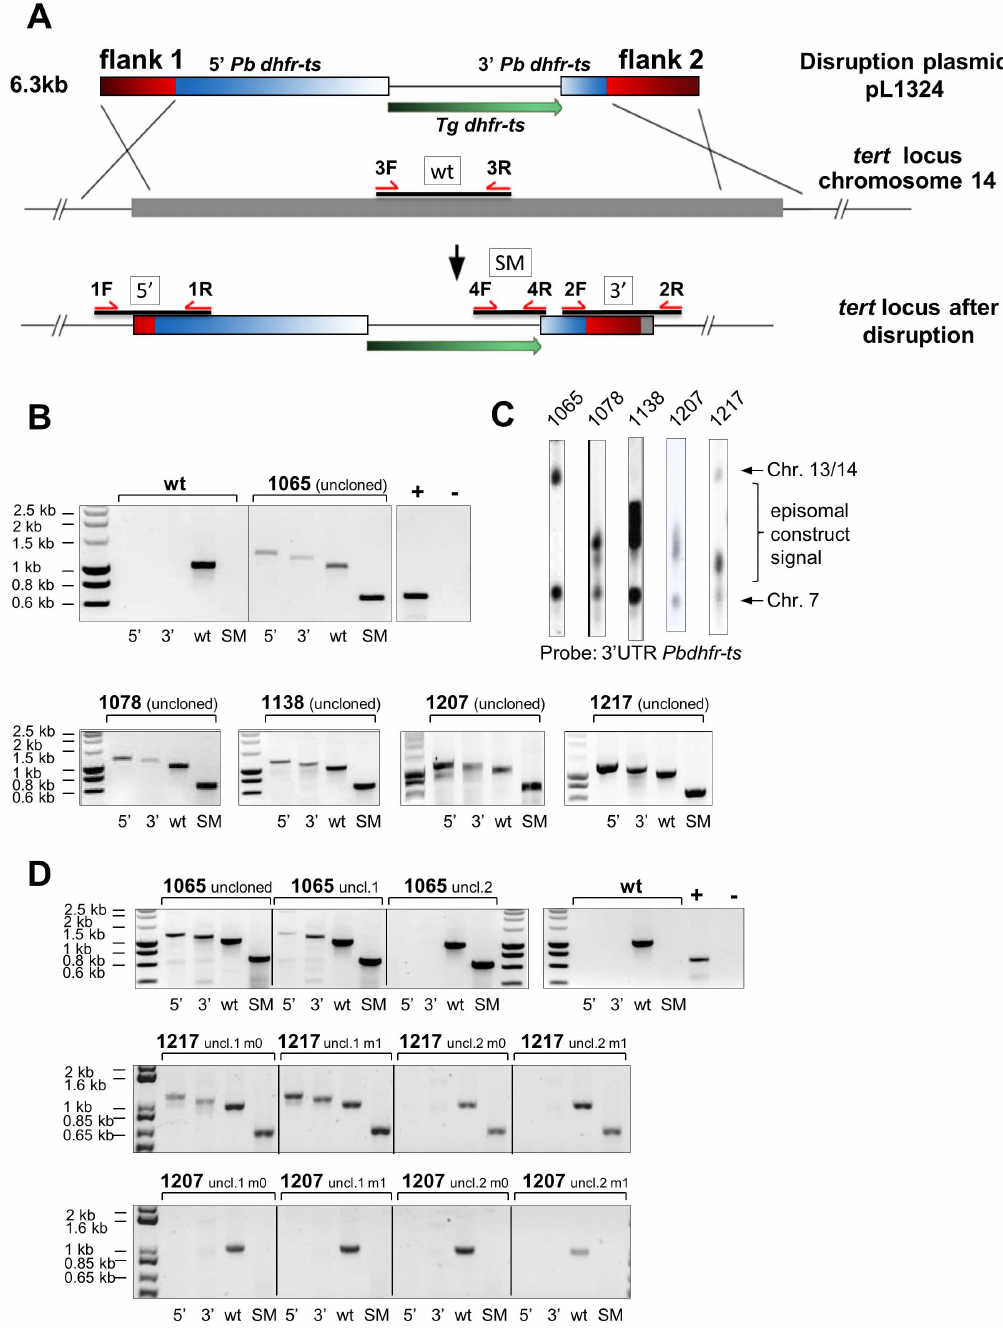
Figure 3. Pbtert deletion and selection of tert- mutants. (A) Schematic representation of the construct used to delete the tert gene. The construct, containing the Tgdhfr-ts selectable marker (SM) cassette, targets the tert gene at the flanking regions (red) by double cross-over integration. The red arrows indicate primers used for diagnostic PCR to confirm correct disruption of tert . Boxes correspond to lanes on the PCR gels in (B), (D) and Fig. S1A. (B) Diagnostic PCR of uncloned parasites transfected with a DNA construct to delete the tert gene. Parasites were collected and analysed directly after transfection and selection with pyrimethamine (parent populations). Diagnostic PCR shows the presence of parasites with correct disruption of the tert gene. In all experiments (1065, 1078, 1138, 1207, 1217) the 5 9 and 3 9 integration fragments (lanes 5 9 , 3 9 ), as well as the Tgdhfr-ts fragment (lane SM) were amplified. However, all populations contained parasites with a wild type tert gene as shown by amplification of the wild type tert fragment (lane wt). The primer pairs used are shown in (A) and expected fragment sizes in Table S2. pbs21 -specific primers were used as a positive control for all the PCR reactions (‘‘ + ’’). The water control is marked as ‘‘-‘‘. (C) Southern analysis of separated chromosomes using the 3 9 UTR Pbdhfr-ts probe shows only in experiment 1065 and 1217 hybridisation with chromosome 14 on which the tert gene is located. This probe recognizes the endogenous Pbdhfr-ts gene on chromosome 7 in all populations and additional chromosomes in experiments 1078, 1138, 1207 (possible episomal construct signal). (D) Diagnostic PCR of uncloned and propagated parasites transfected with a DNA construct to delete the tert gene. The